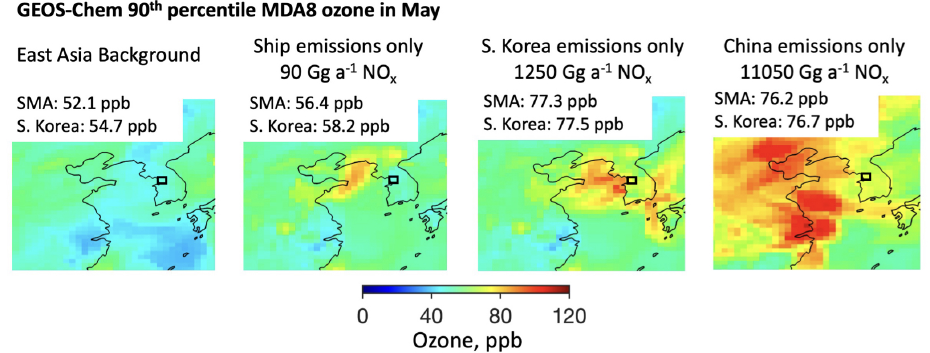
Figure 12. East Asia background ozone and individual enhancements due to anthropogenic emissions from ships in the Yellow Sea (north of 30.5 ◦ N), South Korea and China. Results show the monthly mean 90th percentile MDA8 ozone for May simulated by GEOS-Chem for meteorological year